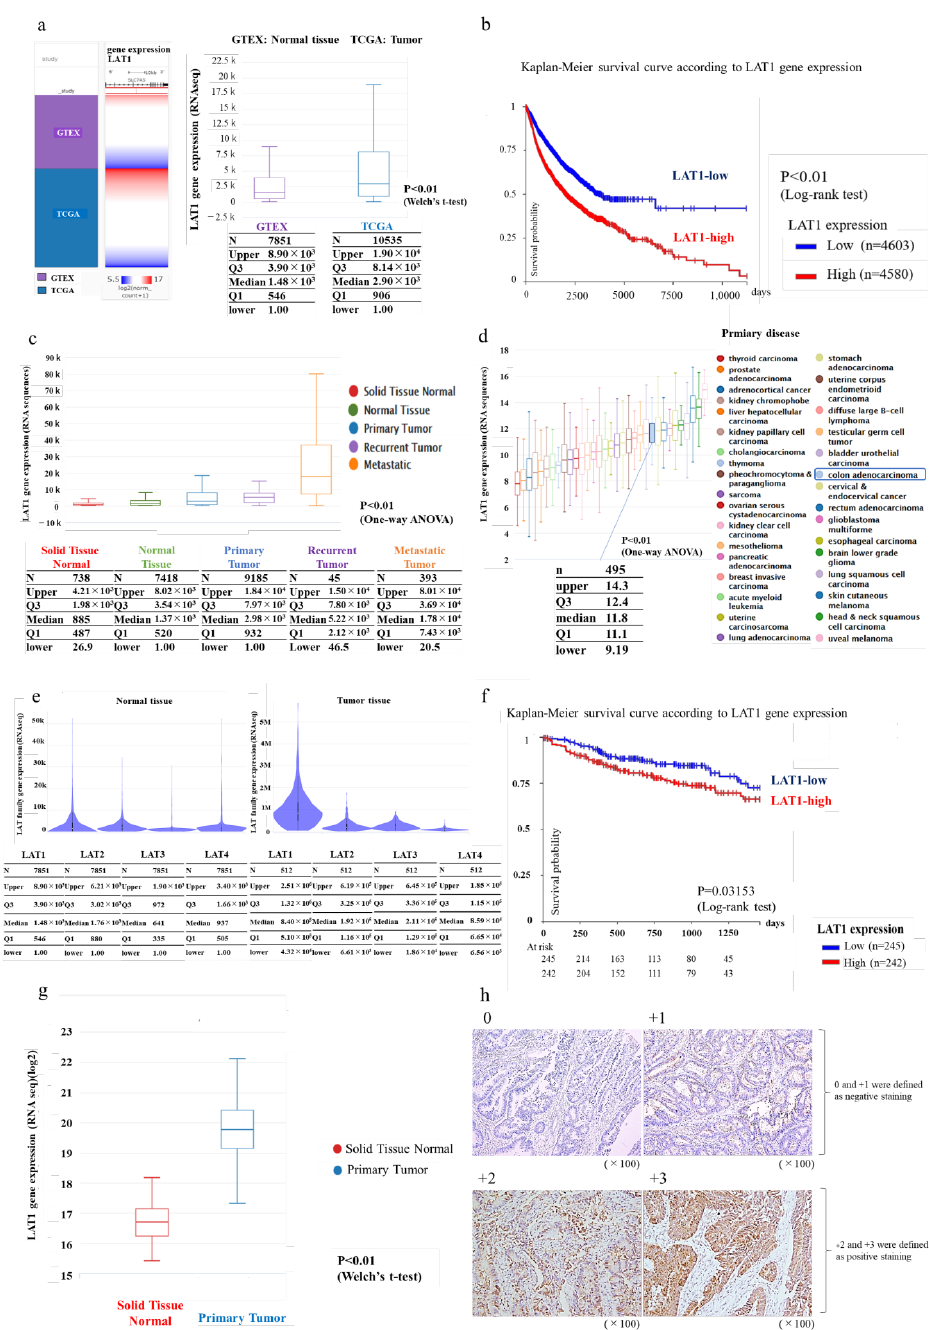
Figure 1. Database analysis based on UCSC cancer genomics browser analysis. ( a ) LAT1 expression in normal and tumor tissues (TCGA TARGET GTEx, 19,131 Samples). Welch’s test was conducted. ( b ) The relationship between LAT1 expression and prognosis in Pan-Cancer (GDC Pan-Cancer, 9372 Samples). The cutoff was set at the median. A log-rank test was conducted. ( c ) LAT1 expression in normal tissue, primary tumor, recurrent tumor, and metastatic tumor (TCGA TARGET GTEx, 19,131 samples). ( d ) LAT1 expression according to the primary site of cancer (TCGA Pan-Cancer, 12,839 samples). ( e ) LAT family expression in normal tissue and colorectal cancer (GTEX, 9783 Sam- ples; TCGA Colon Cancer, 571 samples). ( f ) Relationship between LAT1 expression and prognosis in colorectal cancer (GDC TCGA Colon Cancer (COAD), 571 Samples). The cutoff was set at the median. A log-rank test was conducted. ( g ) LAT1 expression in normal tissue, primary tumor, recurrent tumor, and metastatic tumor (colorectal cancer) (GDC TCGA Colon Cancer (COAD), 571 samples). ( h ) Immunostaining of LAT1 in surgically resected human colorectal cancer